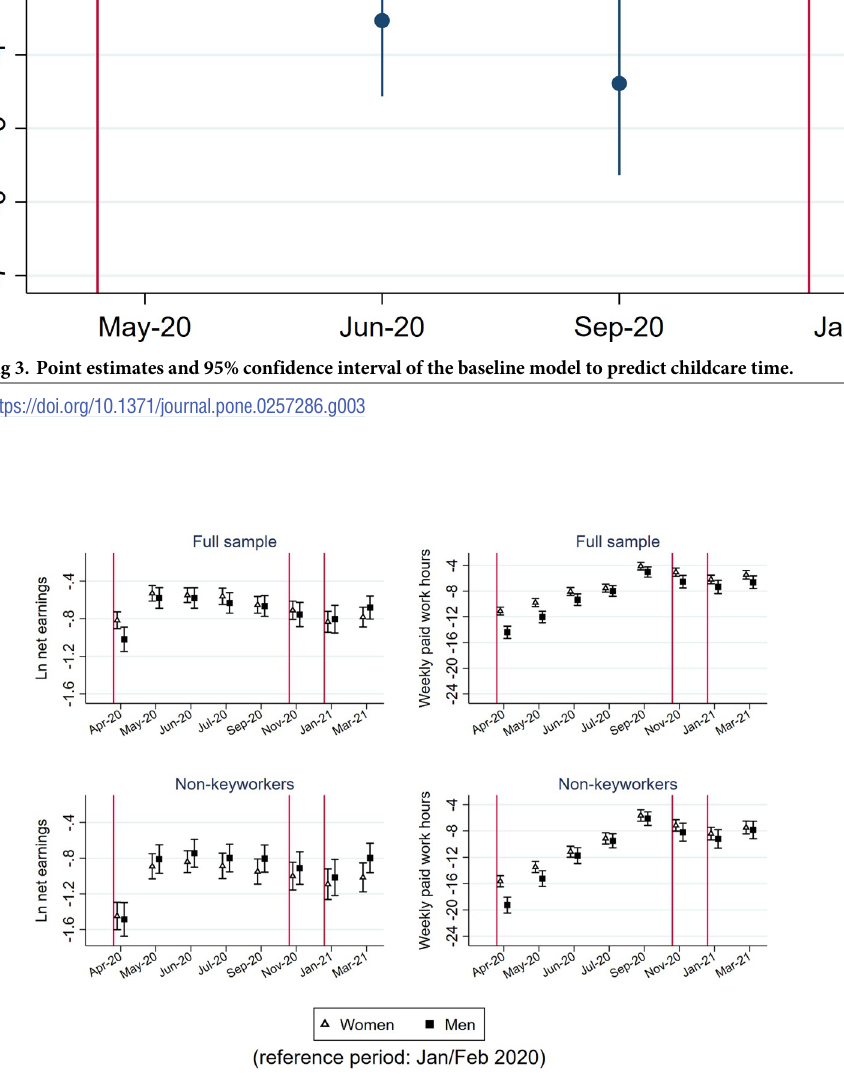
PLOS ONE | https://doi.org/10.1371/journal.pone.0257286 September 29,